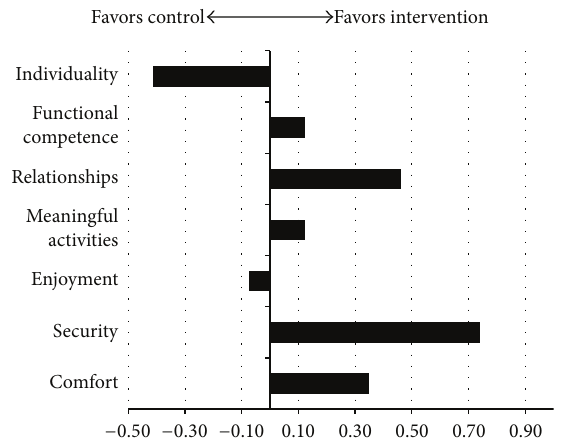
Figure 3: Difference between treatment and control at 180